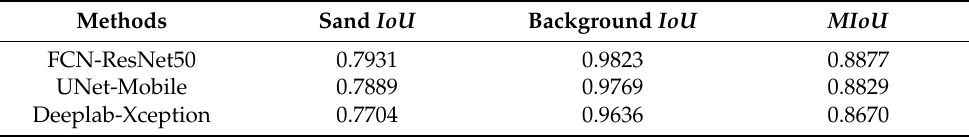
Table 3. Objective evaluation index of each model.